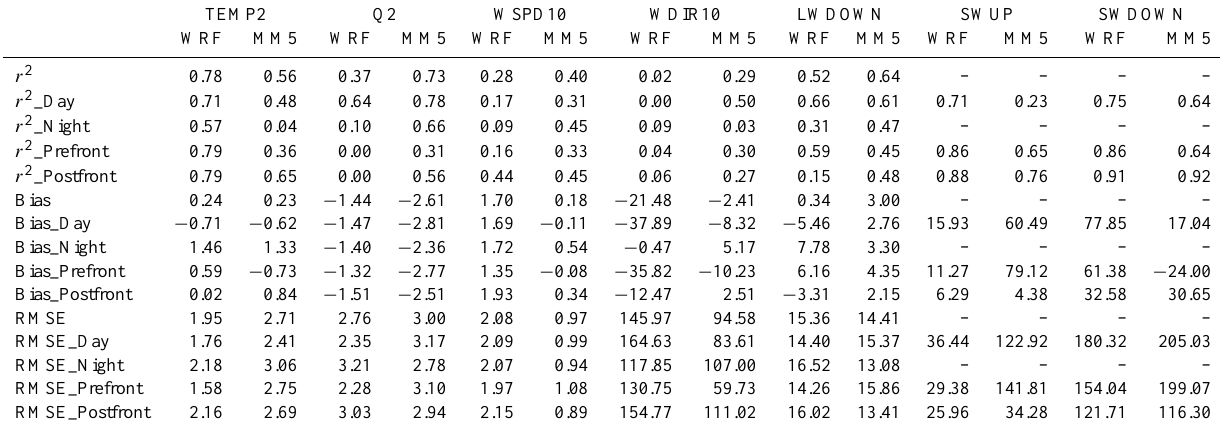
Table 6. Results for r 2 and bias for all, diurnal, and frontal conditions for temperature (TEMP2), water vapor mixing ratio (Q2), wind speed (WSPD10), wind direction (WDIR), incoming longwave radiation (LWDOWN), outgoing shortwave radiation (SWUP), and incoming shortwave radiation